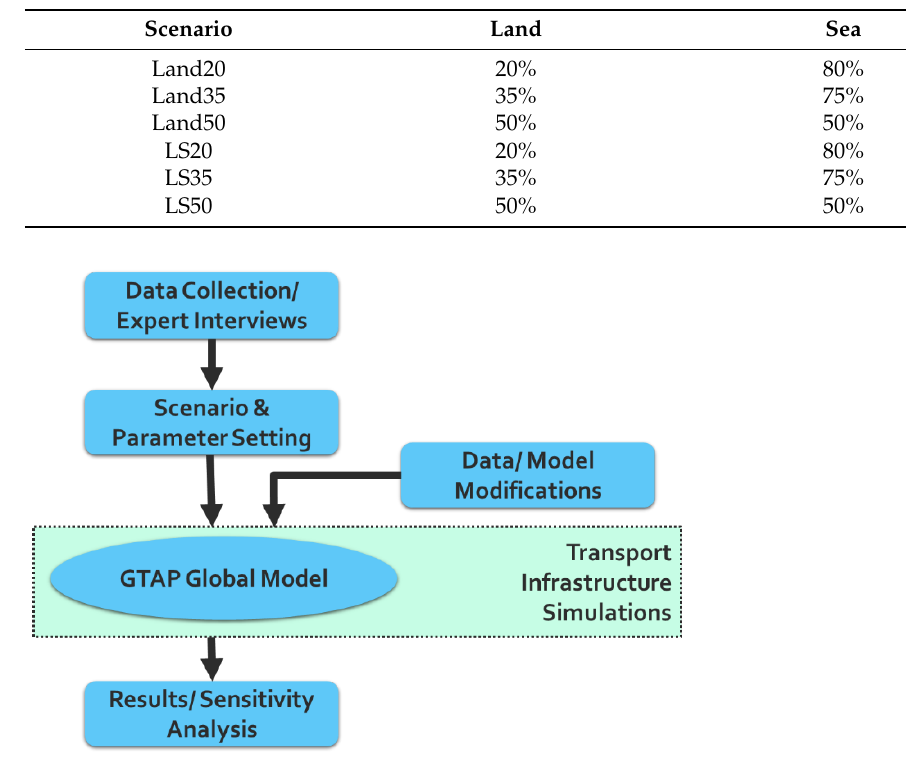
Figure 1. Analytical framework.